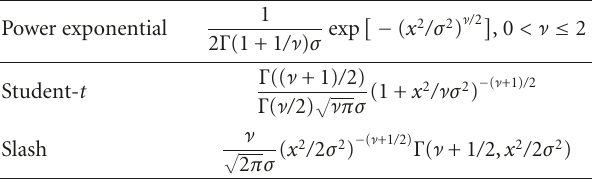
Table 1: Three heavy-tailed distributions are presented, where function and incomplete gamma function, respectively. We assume ν is a fixed parameter. Power